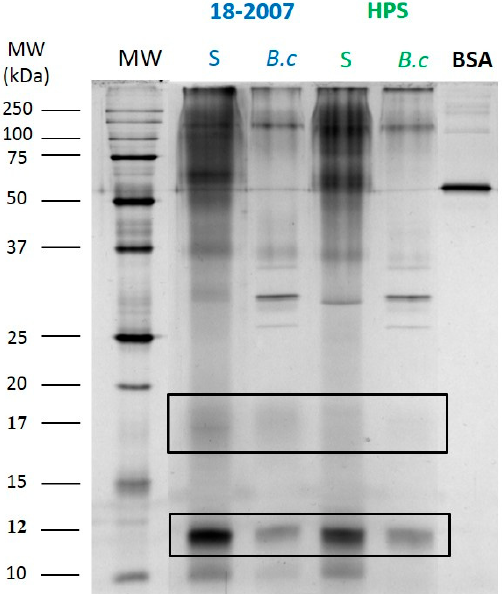
Figure 3. One-dimensional SDS-PAGE analysis of the secreted proteins from the enological Saccharomyces strains 18-2007 and HPS. The wines were concentrated 11× for the silver staining. Relative MWs from the standards are given on the left side of the gels. 12 and 17: proteins at 12 and 17 kDa. BSA: 30 ng loaded to calculate the yeast total proteins and the 12 kDa protein in the wines.